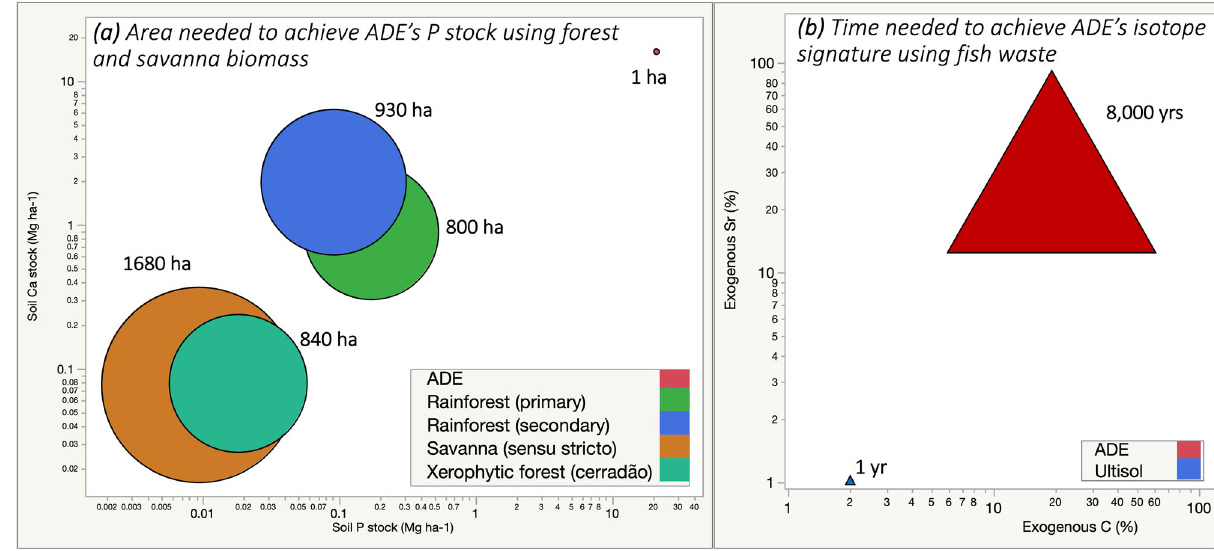
Fig. 1 Nutrient stocks needed to form Amazonian Dark Earths (ADEs). a The coordinates of the points show the measured P and Ca stocks in the top 1m of soil (log-scale axis) in ADEs 1 and in above-ground biomass of tropical forests and savannas 20 – 23 . The size of circles: (not logged) represents the area needed to concentrate P from the biomass of each ecosystem into a 1-hectare ADE patch (upper-right point) to achieve the observed fertility. The areas are calculated as the quotient of the P stock in 1ha of ADE soil and the P concentration in above-ground biomass (e.g., for primary rainforest). These estimates combine wood and foliage biomass measured in contemporary landscapes 20 – 23 conservatively assuming no elemental loss after biomass deposition or burning. b The coordinates of the points show the estimated amount of organic C and Sr mass in the top 1m of soil (log-scale axis), originating from exogenous inputs based on isotopic signatures as presented in Silva et al. 1 For Sr, radiogenic signatures indicate that ~24% of Sr mass in ADE pro fi les originate from either fi shbone or river sediment as both sources have the same Sr isotopic composition. For C, grass-derived biomass from savannas upstream could explain the change in C source through the pro fi le. The size of triangle: (not logged) represents time of occupation needed to achieve ADE nutrient